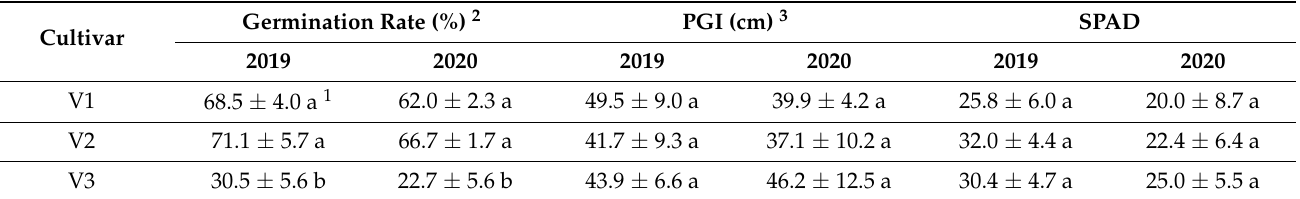
Table 1. Germination rate, plant growth index (PGI), and leaf SPAD value of three danshen cultivars grown in Mississippi, United States in 2019 and 2020.